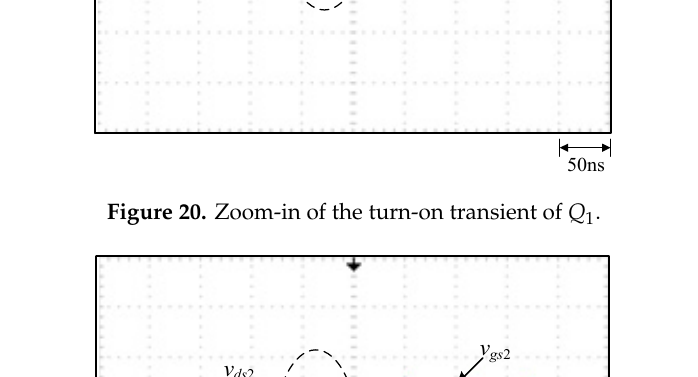
Figure 20. Zoom-in of the turn-on transient of Q 1 .